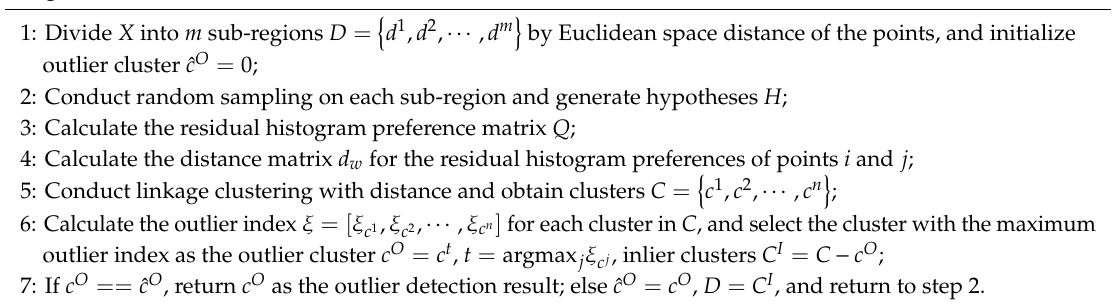
Algorithm 1 Outlier Detection